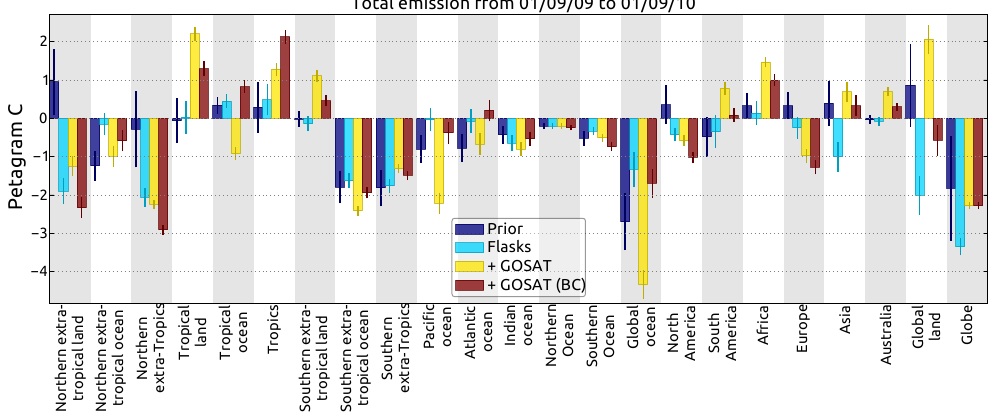
Fig. 13. The optimized flux over some large regions from a joint inversion optimizing bias parameters defined in Eq. 12 (denoted “+ GOSAT (BC)”), compared to the joint inversion shown in Fig. 8 (denoted “+ GOSAT”).